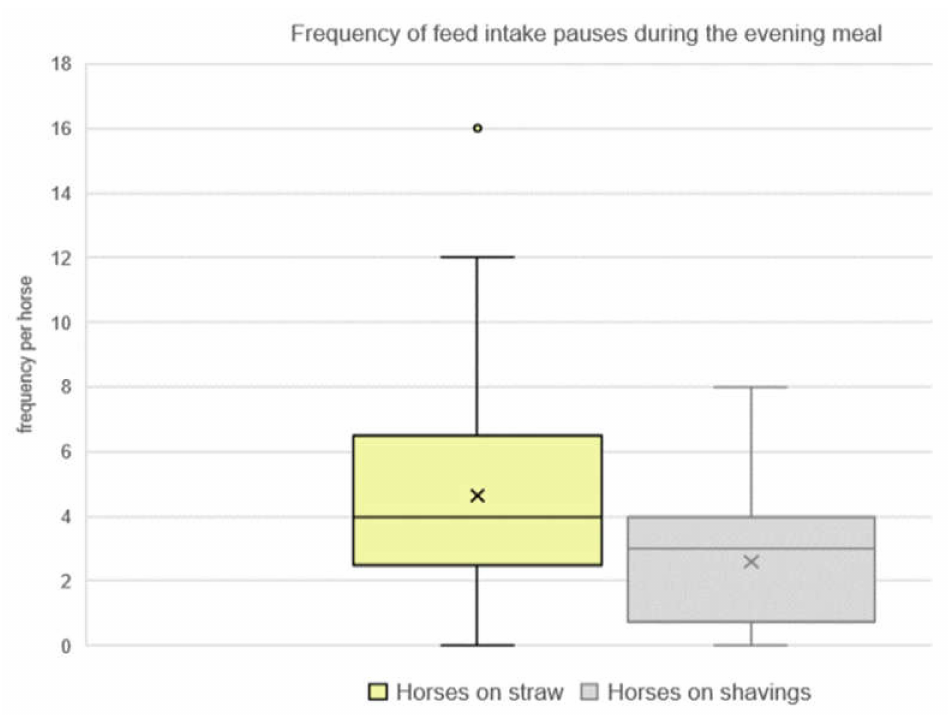
Figure 3. Frequency of feed intake pauses during the evening meal of horses on straw compared to horses on shavings ( n = 55 horses; median: 4.0 of n = 25 horses on straw; median: 3.0 of n = 30 horses on shavings, p =